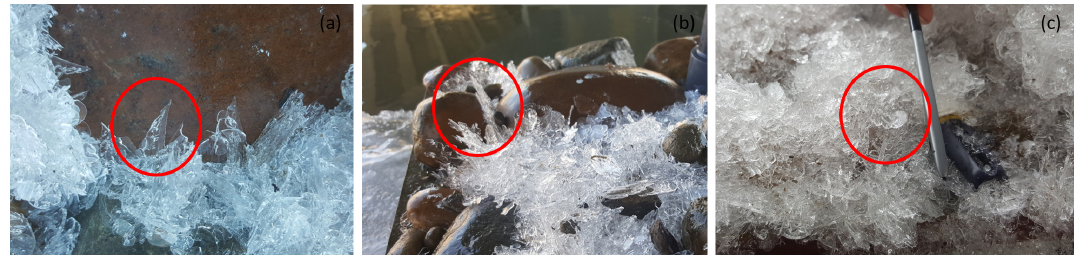
Figure 10. Observed anchor ice crystal types (highlighted with red circles) from the 2018 freeze-up season showing (a) curved needle crystals, (b) platelet crystals, and (c) disk crystals. Table 2. Summary of results for measured anchor ice